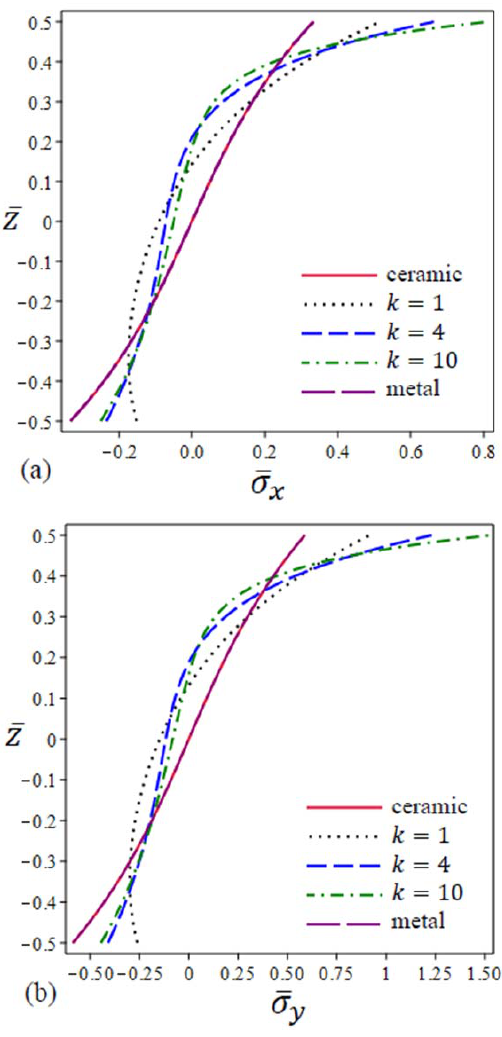
Figure 9: The in-plane axial stresses across the thickness of a FG plate: (a) σ x , (b) σ y .